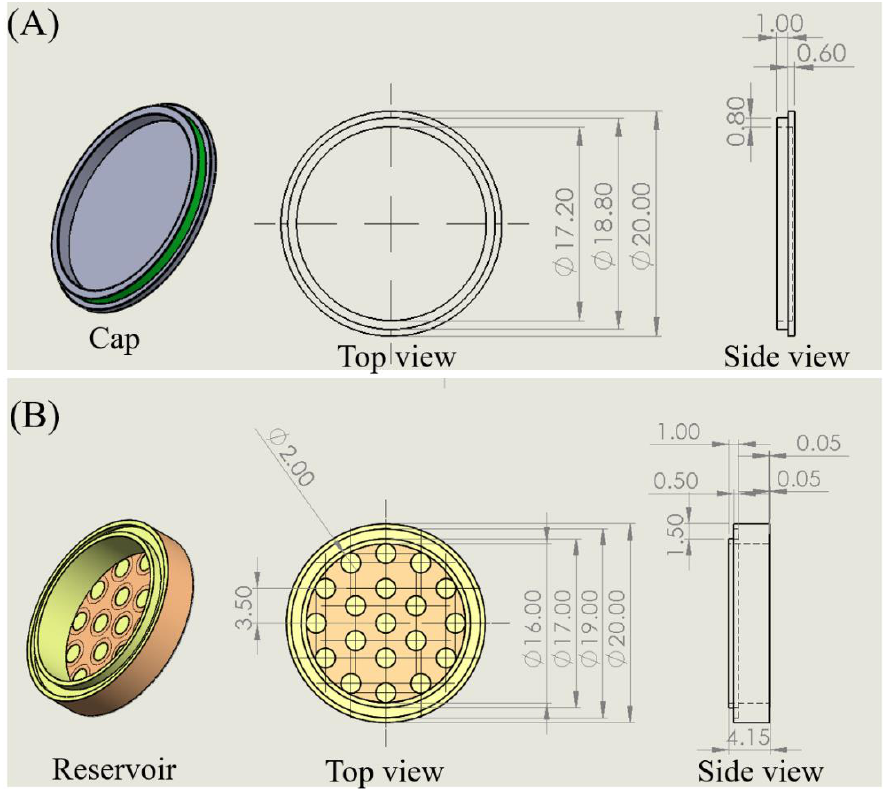
Figure A4. Detail dimension of the cell encapsulation capsule showing the isometric, top, and side view of ( A ) the cap and ( B ) the reservoir. Dimension labeling is in mm.